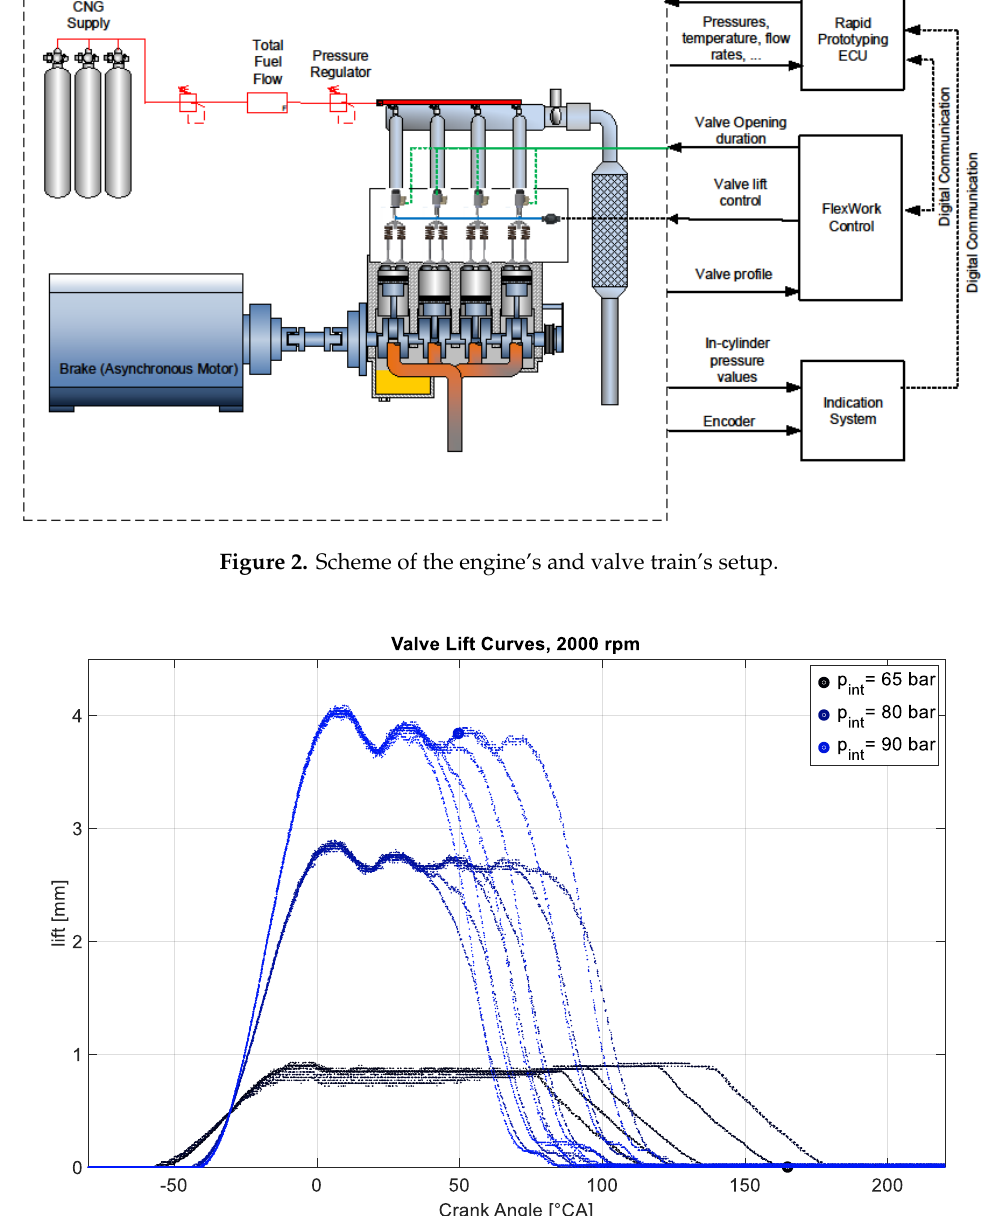
Figure 3. Measured valve lift profiles for different lift- and duration setting of the intake valves.